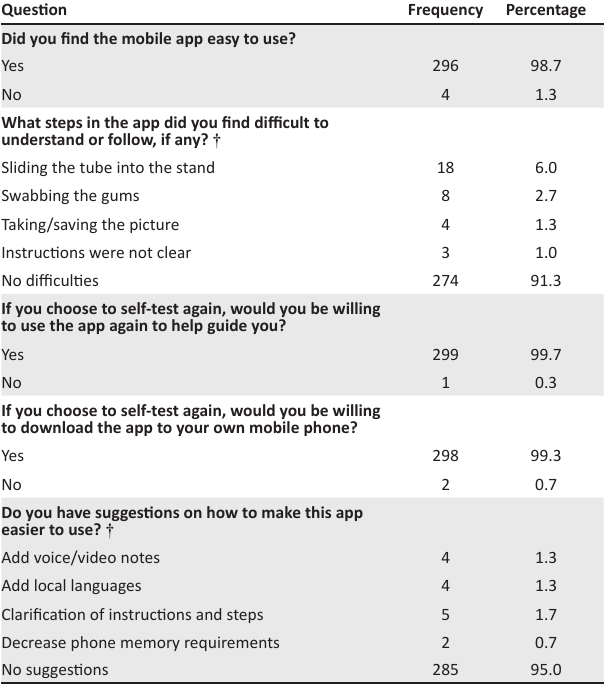
TABLE 3: Acceptability outcomes. Sample size =